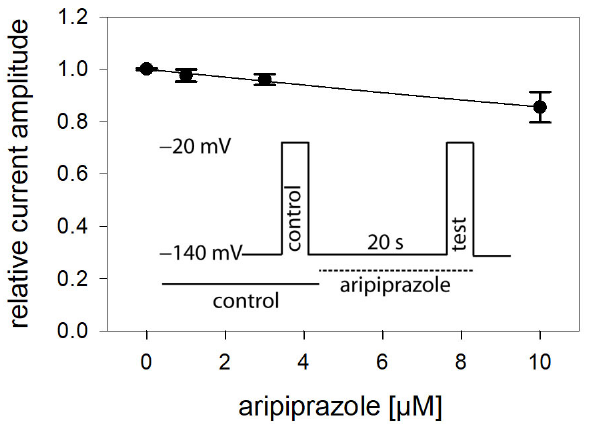
Figure 2. Interaction with the resting state. Relative current amplitudes versus the concentration of aripiprazole are illustrated. Channel activations in the absence (control) and presence of different concentrations of aripiprazole (test) were carried out from a holding potential of − 140 mV (insert). Current amplitudes obtained for the test pulses were related to their controls and plotted against the concentration of aripiprazole. Data points were fit to Equation (1). Note, even at the highest concentration of aripiprazole (10 µ M), the inhibitory effect small. Thus, the calculated affinity (K r : 54.7 ± 13.0 µ M) has to be considered as an approximate